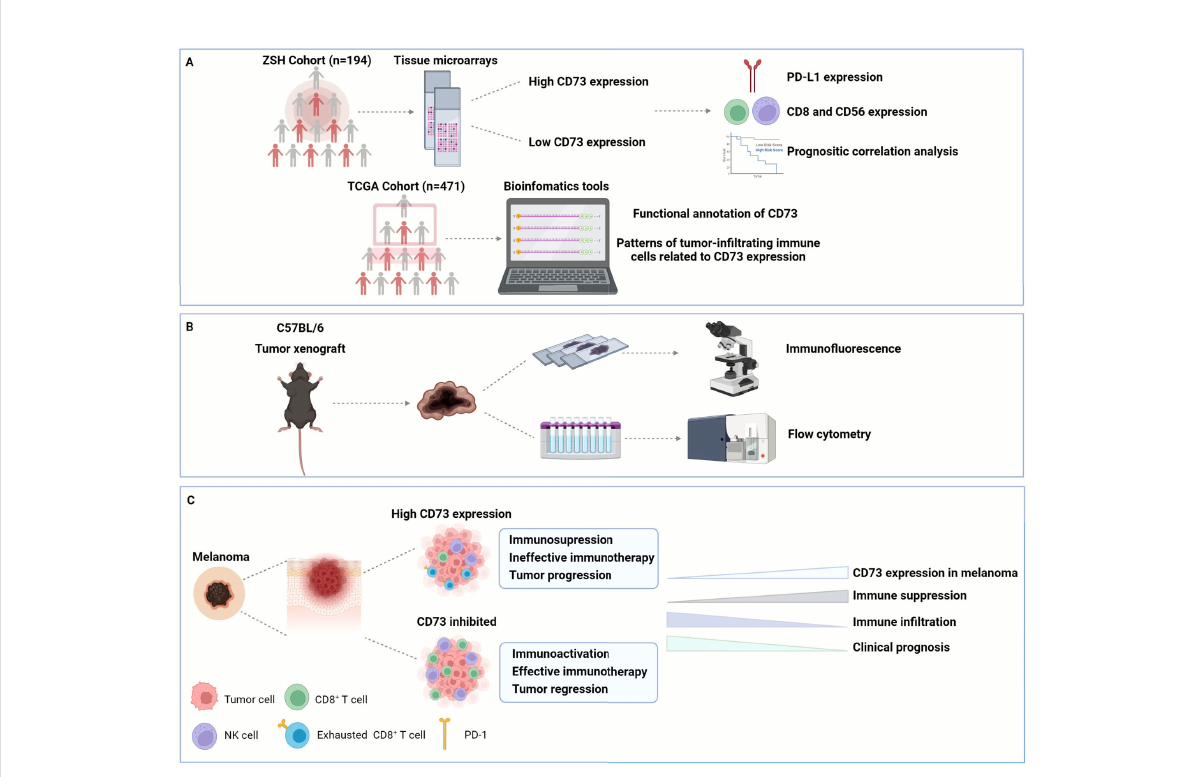
FIGURE 8 Graphical abstract. In this study, we enrolled two cohorts of 194 melanoma patients from Zhongshan Hospital to explore the expression of CD73, PD- L1, CD8 and CD56 in their tumor tissues, and con fi rmed the poor OS and DFS in CD73 high patient subgroup. We also investigated the functional enrichment and patterns of in fi ltrating immune cells related to CD73 by analyzing RNA-seq of 471 melanoma patients from TCGA (A) . Furthermore, we established tumor xenograft of melanoma to explore the role of CD73 in tumor progression and its impact on TME (B) . CD73 high tumors showed an inhibitory TME with fewer CD8 + T cells in fi ltration displaying a dysfunctional phenotype, which could be reactivated when treated with CD73 inhibitor (C) . OS, overall survival; DFS, disease-free survival; TCGA, the Cancer Genome Atlas; TME, tumor